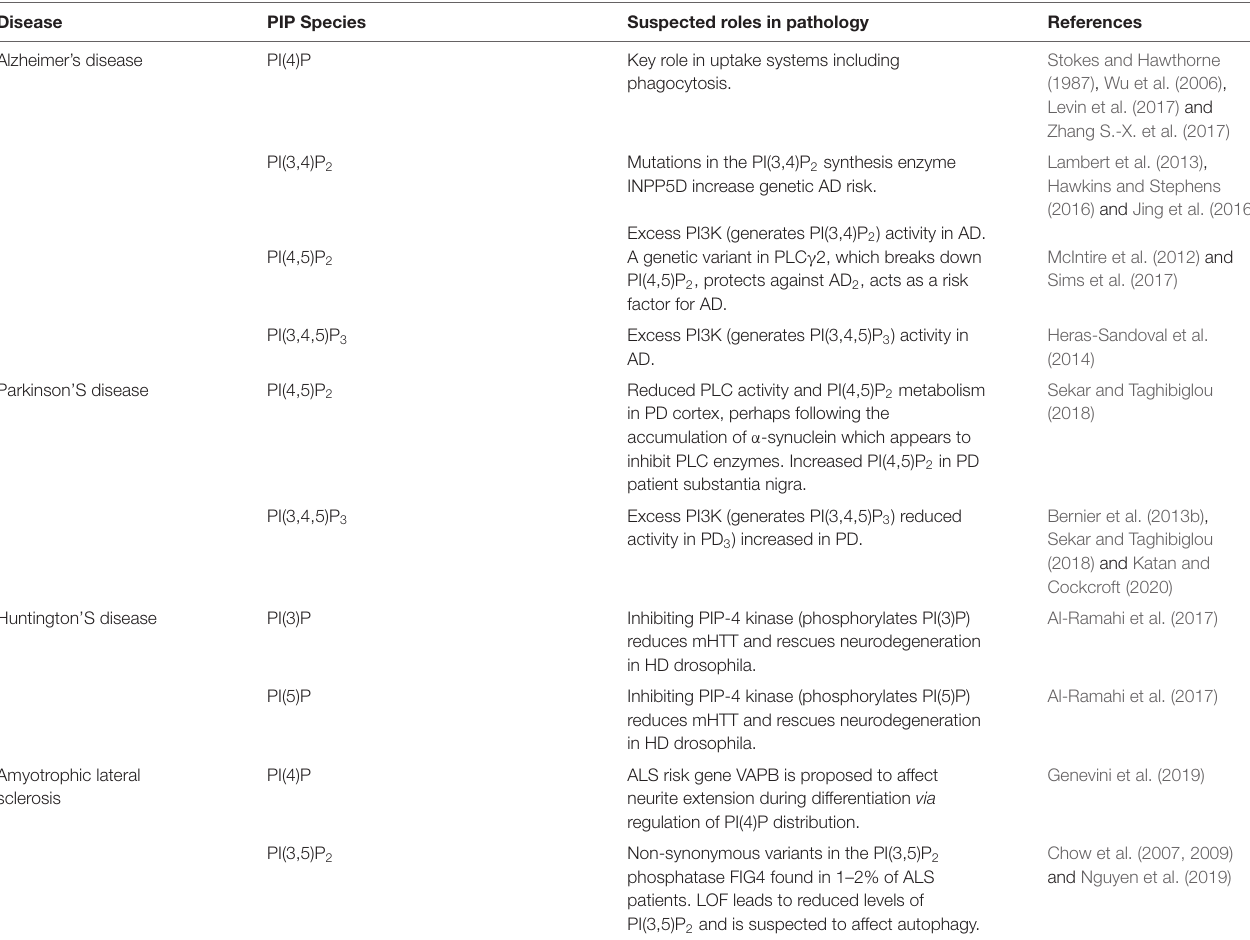
TABLE 2 | The role of PIP species in different neuroinflammatory conditions. Disease PIP